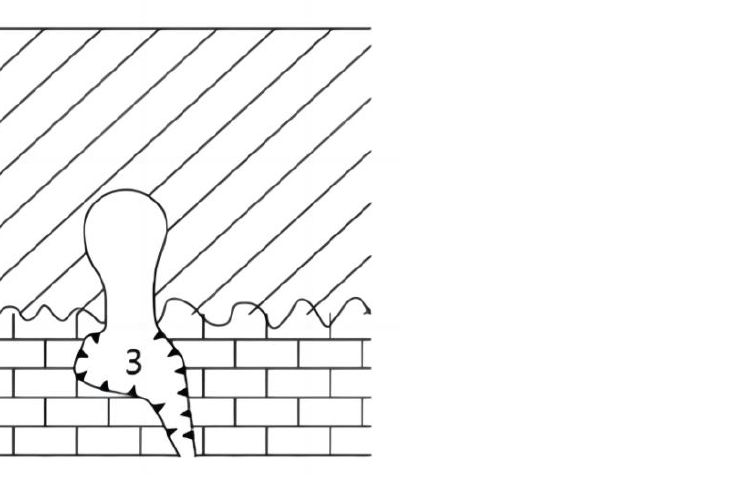
Figure 2. Geological generalization of a single structure. 1—Overburden clayey soil; 2—Limestone; 3—Caves.